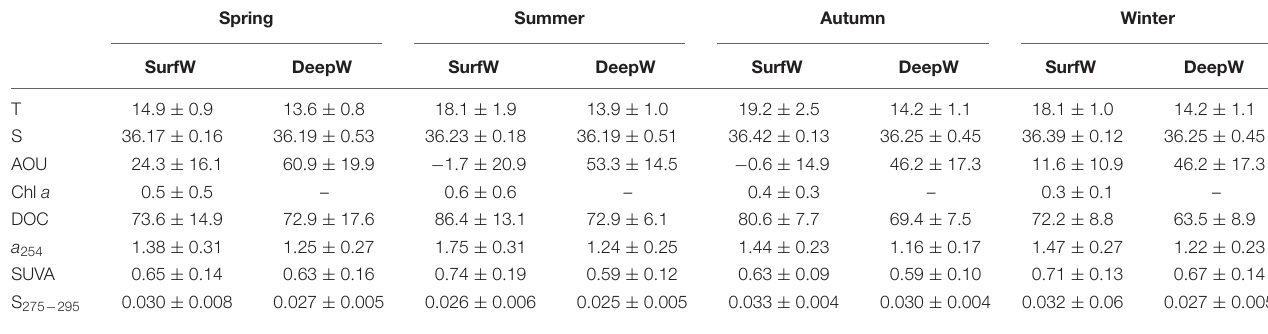
TABLE 1 | Average ± standard deviation values of temperature (T, ◦ C), salinity (S), apparent oxygen utilization (AOU, µ M), chlorophyll a (Chl a , µ g L − 1 ), dissolved organic carbon (DOC, µ M), CDOM absorption coefficient at 254 ( a 254 , m − 1 ), SUVA 254 index (L mg − 1 m − 1 ) and the spectral slope S 275 − 295 (nm − 1 ) from surface (SurfW) and deep water